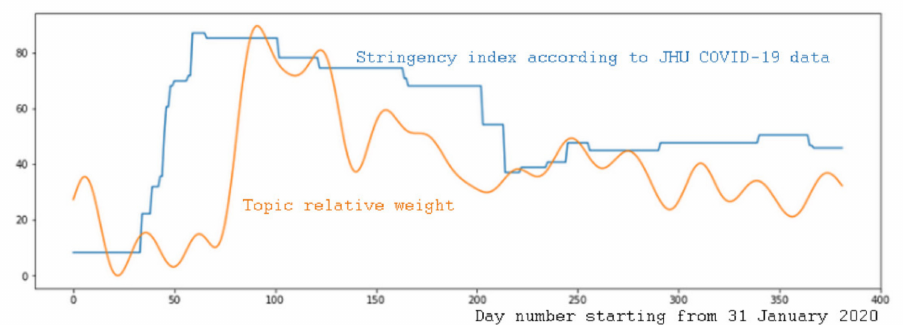
Figure 8. Blue line shows quarantine limitations index in Russia over time, orange line shows dynamic weight of topic with the highest correlation (0.75) over time. The topic is related to the reports on newly identified COVID-19 cases across the different regions of the country.